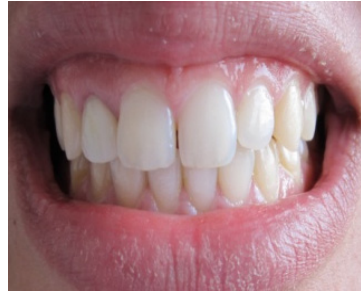
Figure 2. Gingival display due to the asymmetrical